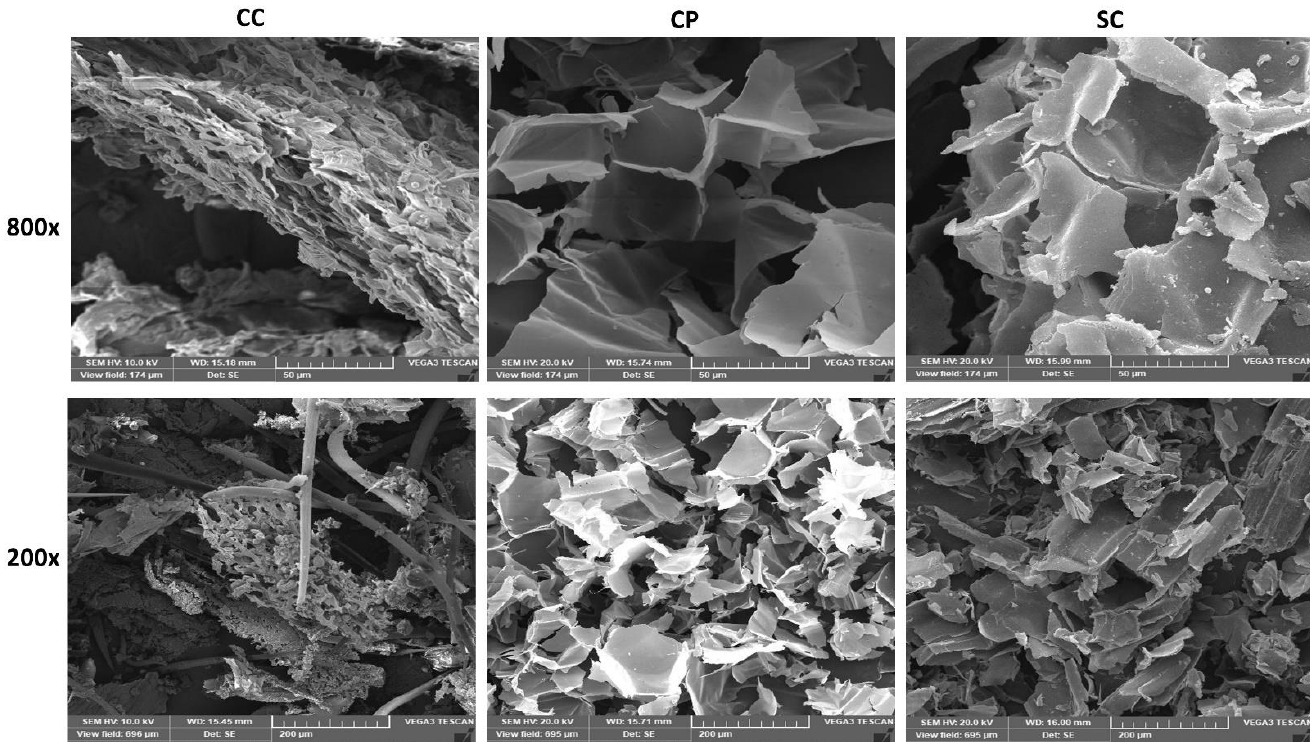
Figure 2. The X-ray diffraction (XRD) spectra of lignocellulosic biomasses, including corn cob (CC), cornstalk piths (CP) and sugarcane bagasse (SC).